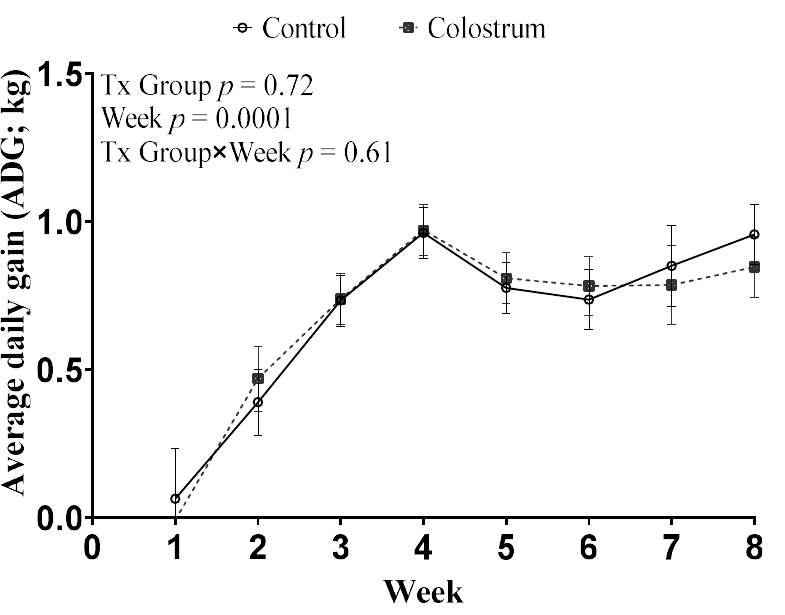
Figure 2. Least squares means of repeated measures ANOVA of ADG during the pre-weaning period. Treatments: control (CON) received 4 L of colostrum within 2 h of life followed with 3 L of acidified milk within 12–16 h later; Colostrum (COL) received 4 L of colostrum within 2 h of life followed with another 3 L of colostrum 12–16 h later. Error bars represent standard error. Enrollment block was included as a random effect.